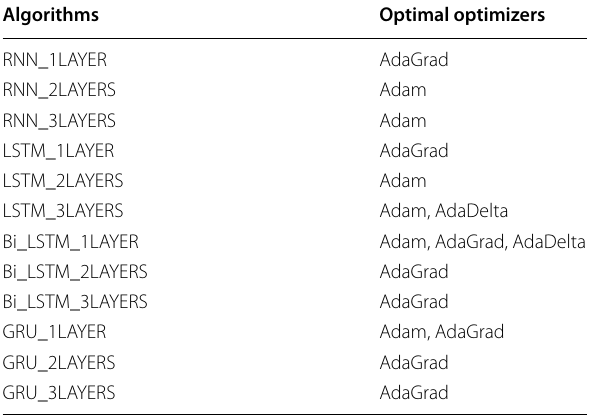
Table 3 Optimal optimizers for different algorithms Algorithms Optimal optimizers